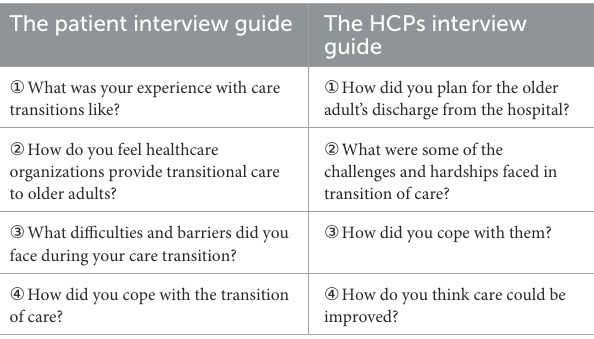
TABLE 1 Interview topic guide of the older patients and